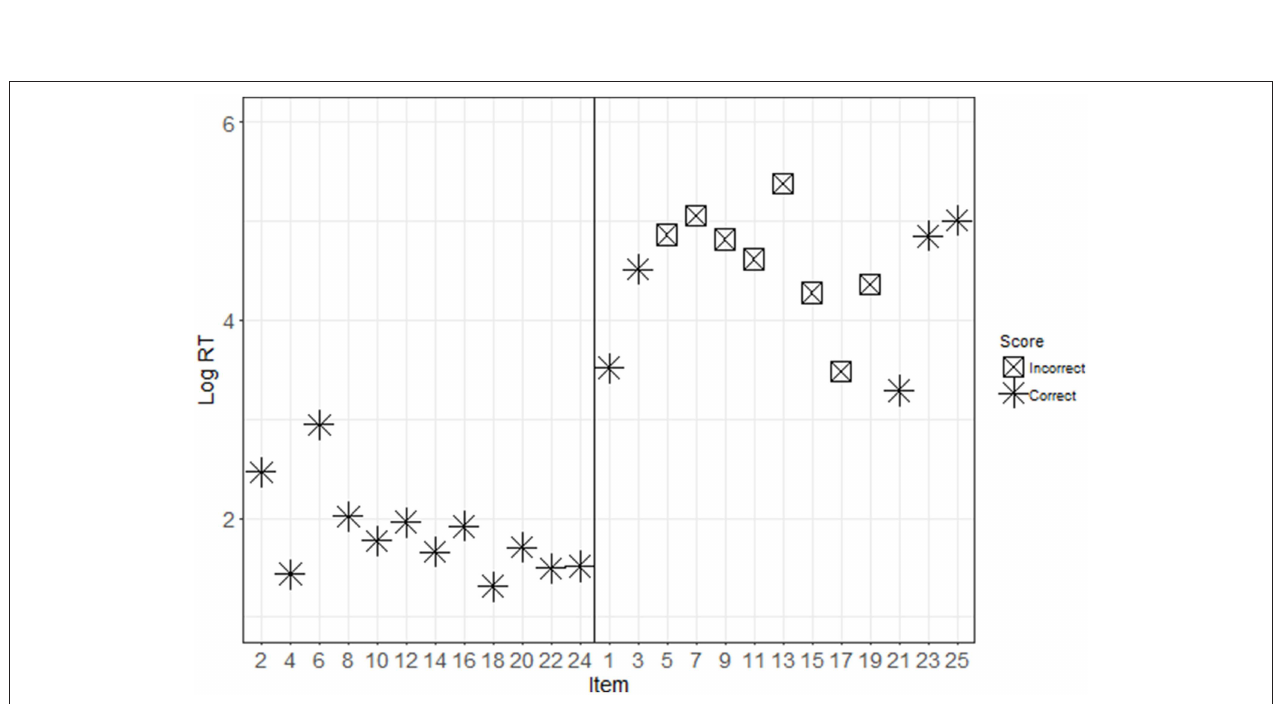
FIGURE 2 | Response patterns for a control participant. This figure shows the item scores (see marker shape) and log RTs (y-axis) for disclosed (even, presented on the left) and undisclosed (odd, presented on the right) items. Note that for this control participant, there is no discernable difference between the response patterns for the disclosed and undisclosed items.